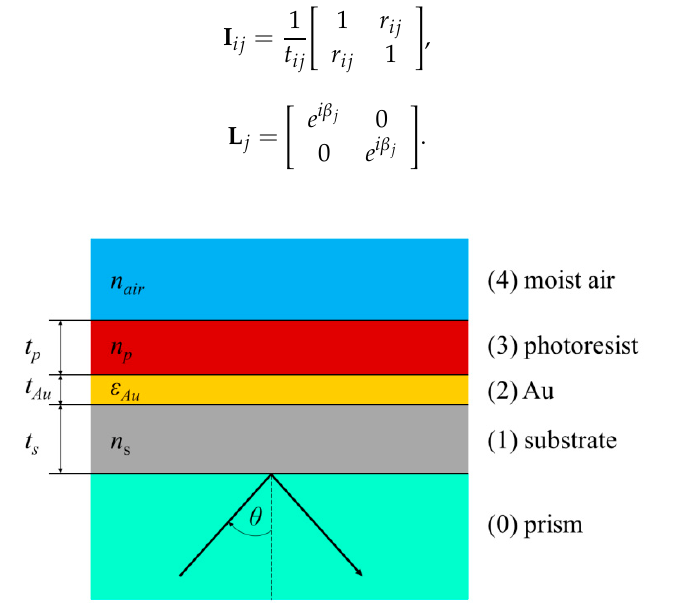
Figure 1. Scheme of the planar waveguide structure (PWS).